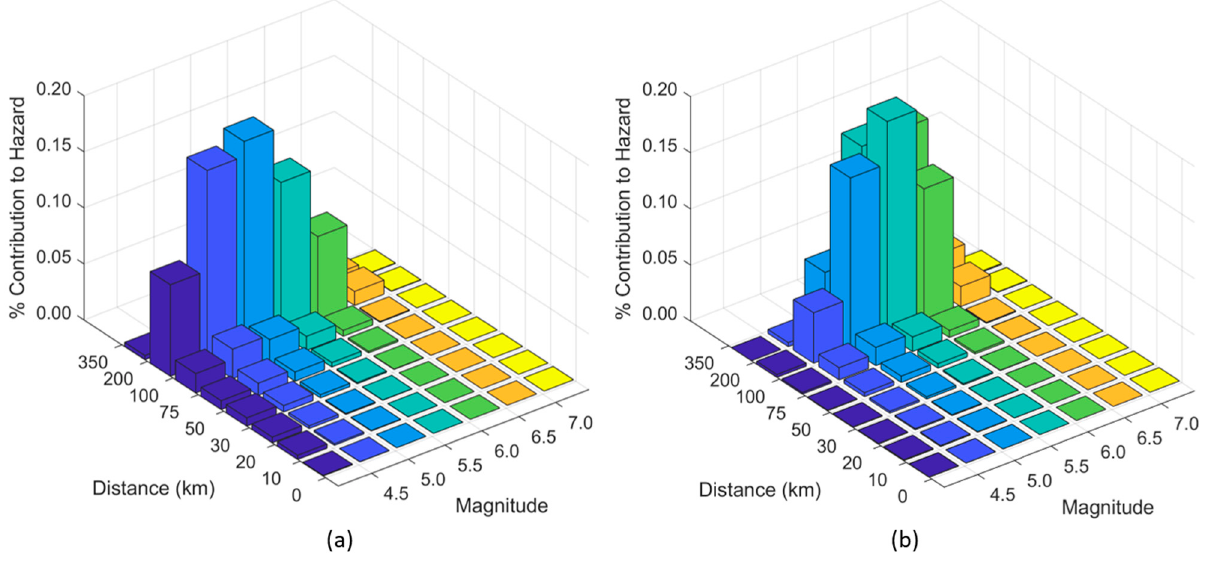
Figure 7. Hazard deaggregation for ( a ) PGA and ( b ) Sa ( T = 1) on rock for 475-year return period.